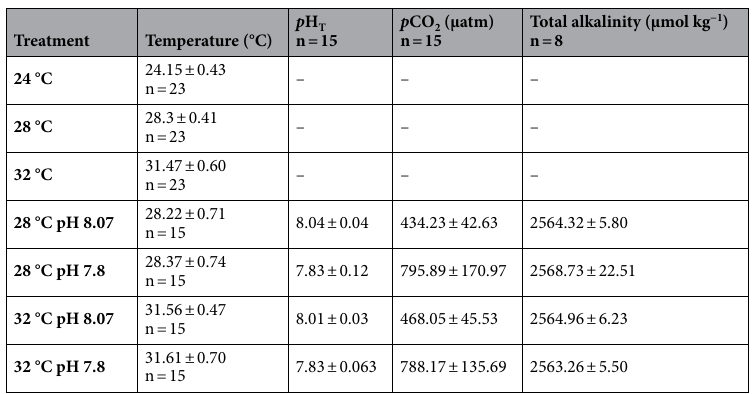
Table 1. Measured (regular characters) and expected (bold characters) seawater physico-chemical parameters (temperature in °C, p H T in total scale, calculated p CO 2 in µatm, and total alkalinity in µmol kg −1 with MEAN ± SD) according to different